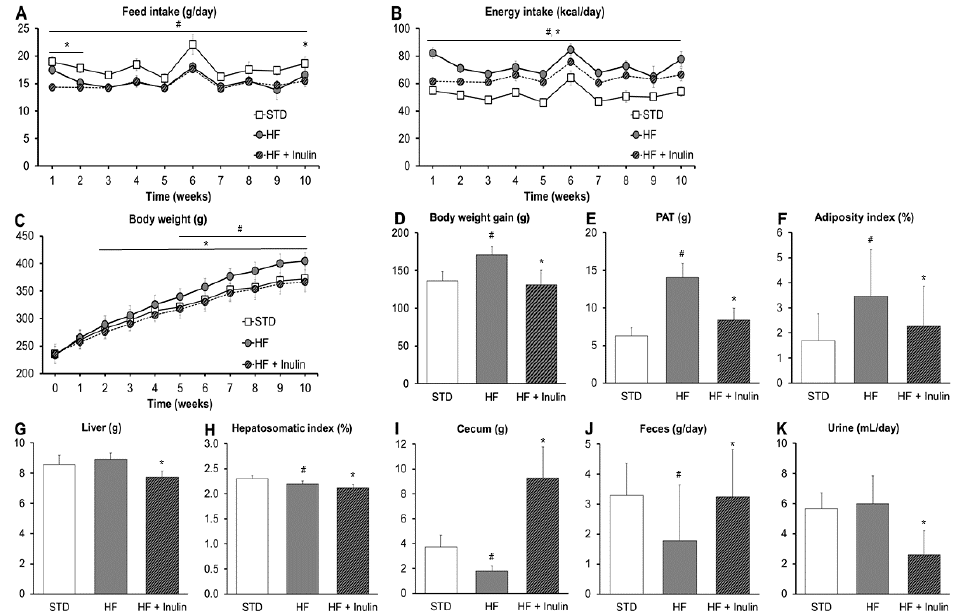
Figure 2. Characteristics of rats. ( A ) Daily feed intake throughout the study. ( B ) Daily energy intake throughout the study. ( C ) Body weight throughout the study. ( D ) Body weight gain (final body weight–initial body weight). ( E ) Perigonadal adipose tissue weight. ( F ) Adiposity index (perigonadal adipose tissue weight/body weight × 100). ( G ) Liver weight. ( H ) Hepatosomatic index (liver weight/body weight × 100). ( I ) Cecum weight. ( J ) Feces in metabolic cages for 24 h during week 5. ( K ) Urine in metabolic cages for 24 h during week 5. Values are expressed as mean with standard deviation. Abbreviations: STD, standard diet; HF, high-fat diet containing 34% sucrose; HF + Inulin, modified HF diet containing 19% sucrose and 15% inulin. p -values were calculated using the t -test or the non-parametric Mann–Whitney U test. # p -value < 0.05 vs. STD; and * p -value < 0.05 vs.